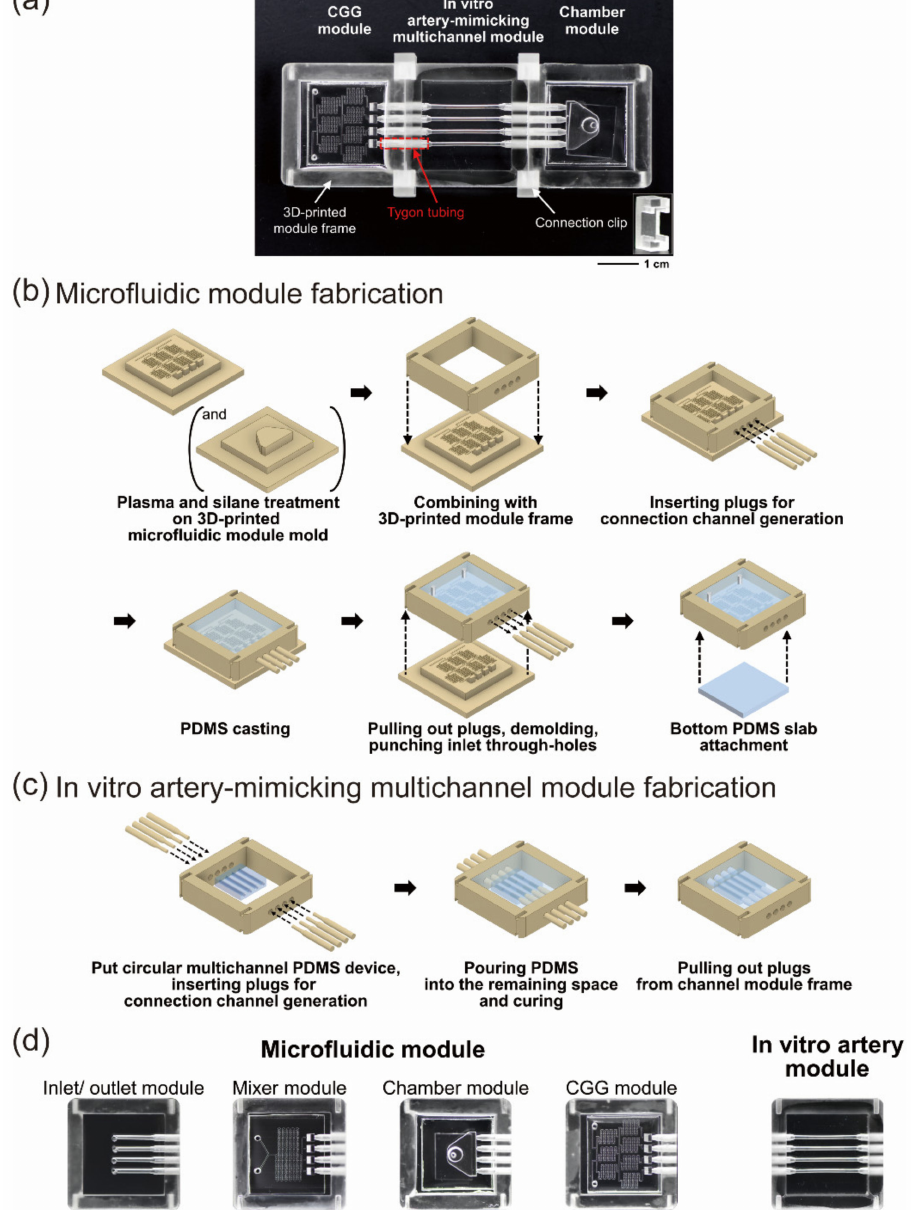
Figure 2. Module fabrication process of a modular three-dimensional (3D) in vitro artery-mimicking multichannel device. ( a ) Digital image of an assembled modular device. The modules were assembled using connection clips (inset). ( b ) Fabrication process of a microfluidic concentration gradient gener- ator (CGG) module and a chamber module. ( c ) Fabrication process of an in vitro artery-mimicking multichannel module. ( d ) Fabricated microfluidic modules and an in vitro artery-mimicking module. Various microfluidic modules can be easily fabricated by changing the design of three-dimensionally printed molds, interchanged and used, depending on the analysis. Various structures of channels in the artery-mimicking multichannel module can be obtained by tuning the multichannel PDMS device design, which is put into the module in the module fabrication